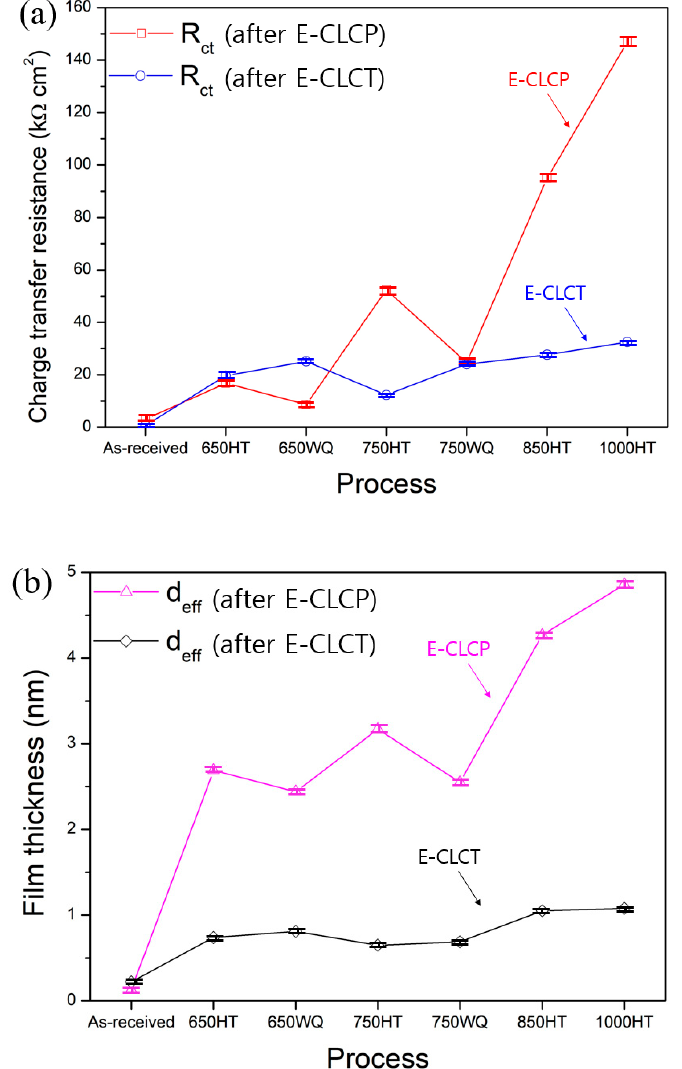
Figure 13. Comparison of ( a ) R ct of EIS tests and ( b ) thickness of passive films ( d eff ) between the E-CLCP and E-CLCT tests for the as-received and various heat-treated AM Ti–6Al–4V alloys using furnace cooling or water quenching methods (HT: furnace cooling; WQ: water quenching).